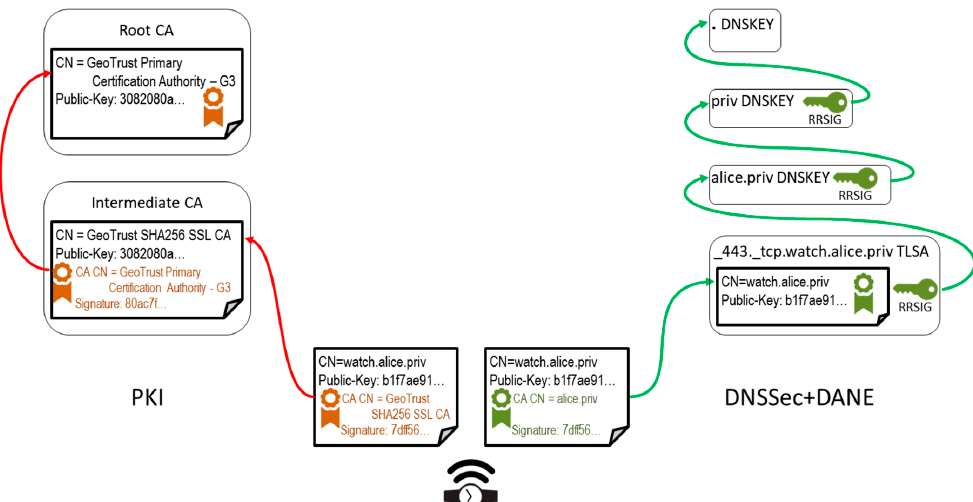
Figure 1. Chains of trust for X.509 certificate presented by a smart device, e.g., a wristwatch. ( Left